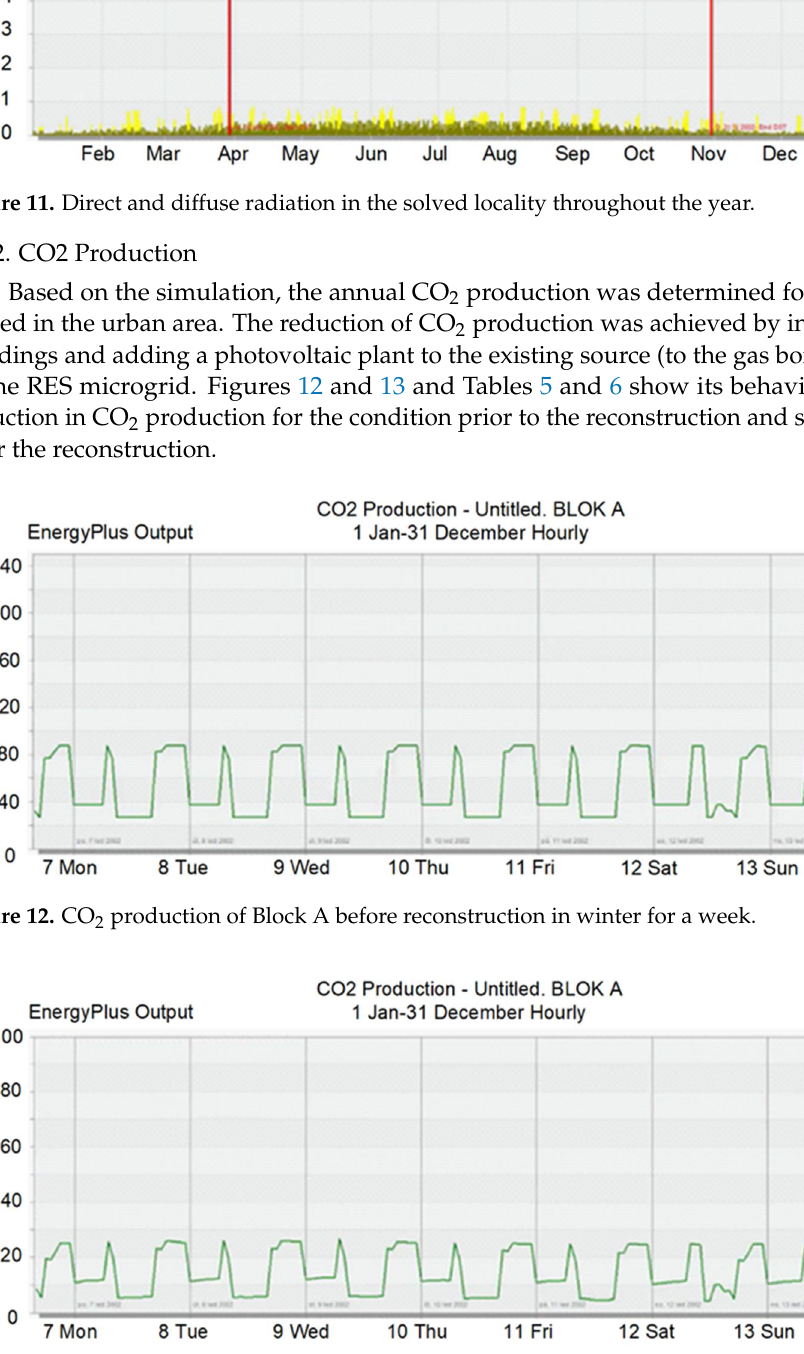
Figure 13. CO 2 production of Block A after reconstruction in winter (weekly section).